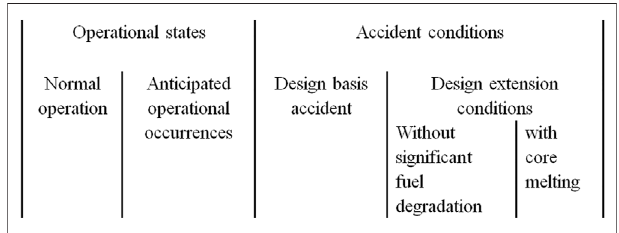
FIGURE 4 | Plant states considered in the design.